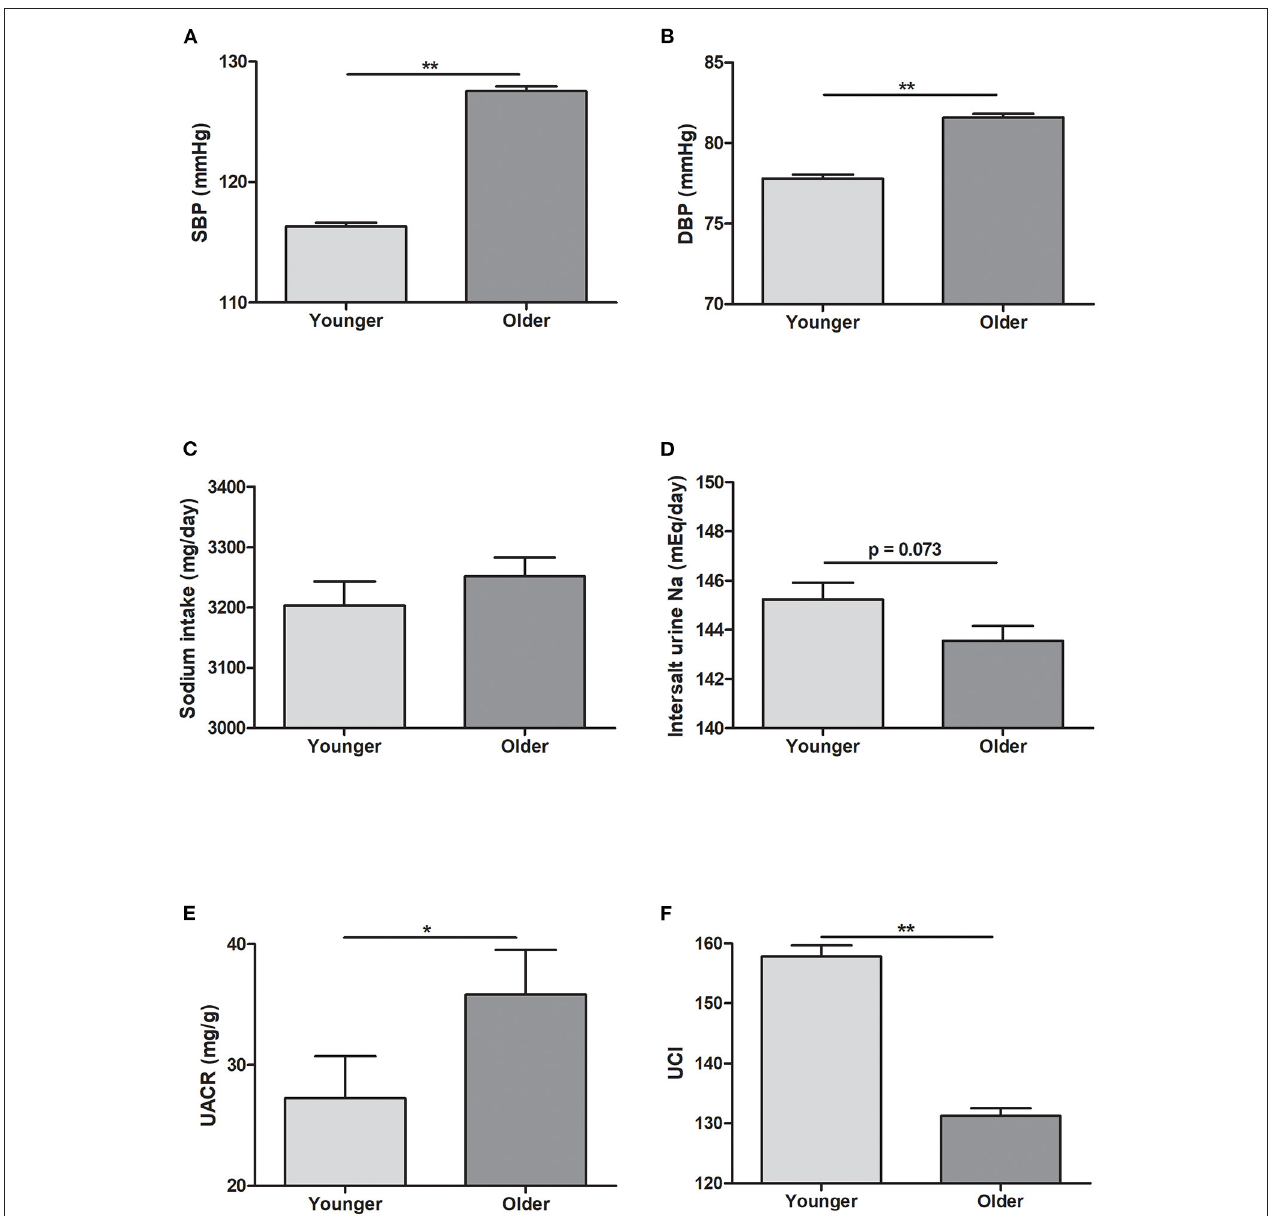
FIGURE 1 | Blood pressure and urine data in the Korean Genome and Epidemiology Study (KoGES). (A) Systolic blood pressure (SBP). (B) Diastolic blood pressure (DBP). (C) Sodium intake (mg/day). (D) Sodium excretion estimated using the INTERSALT equation. (E) Spot urine albumin/creatinine ratio (UACR, mg/g). (F) Urine concentration index (UCI) in the younger and older groups. * p < 0.05 vs. different age group. ** p < 0.01 vs. different age